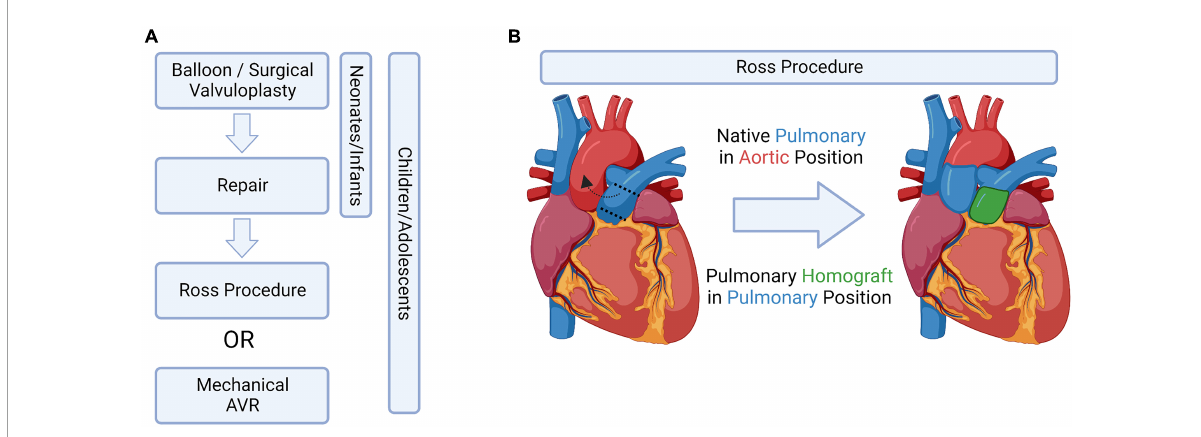
FIGURE4 Current treatment options, bioengineered solutions, and the Ross Procedure. (A) Potential aortic valve intervention strategies in pediatric patients, adapted from Bouhout et al. (91). (B) Schematic drawing of the Ross procedure, which switches the native pulmonary valve into the aortic position. Figure created using BioRender.com (2022).